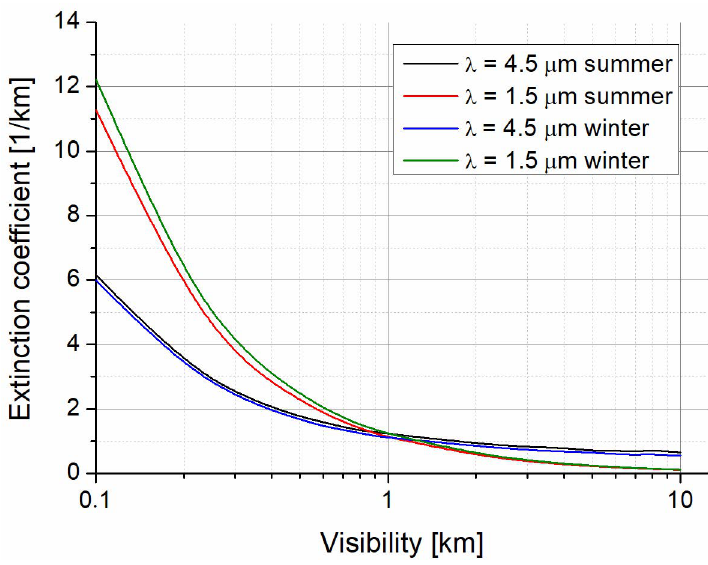
Figure 3. Extinction coefficient for two analyzed wavelengths.